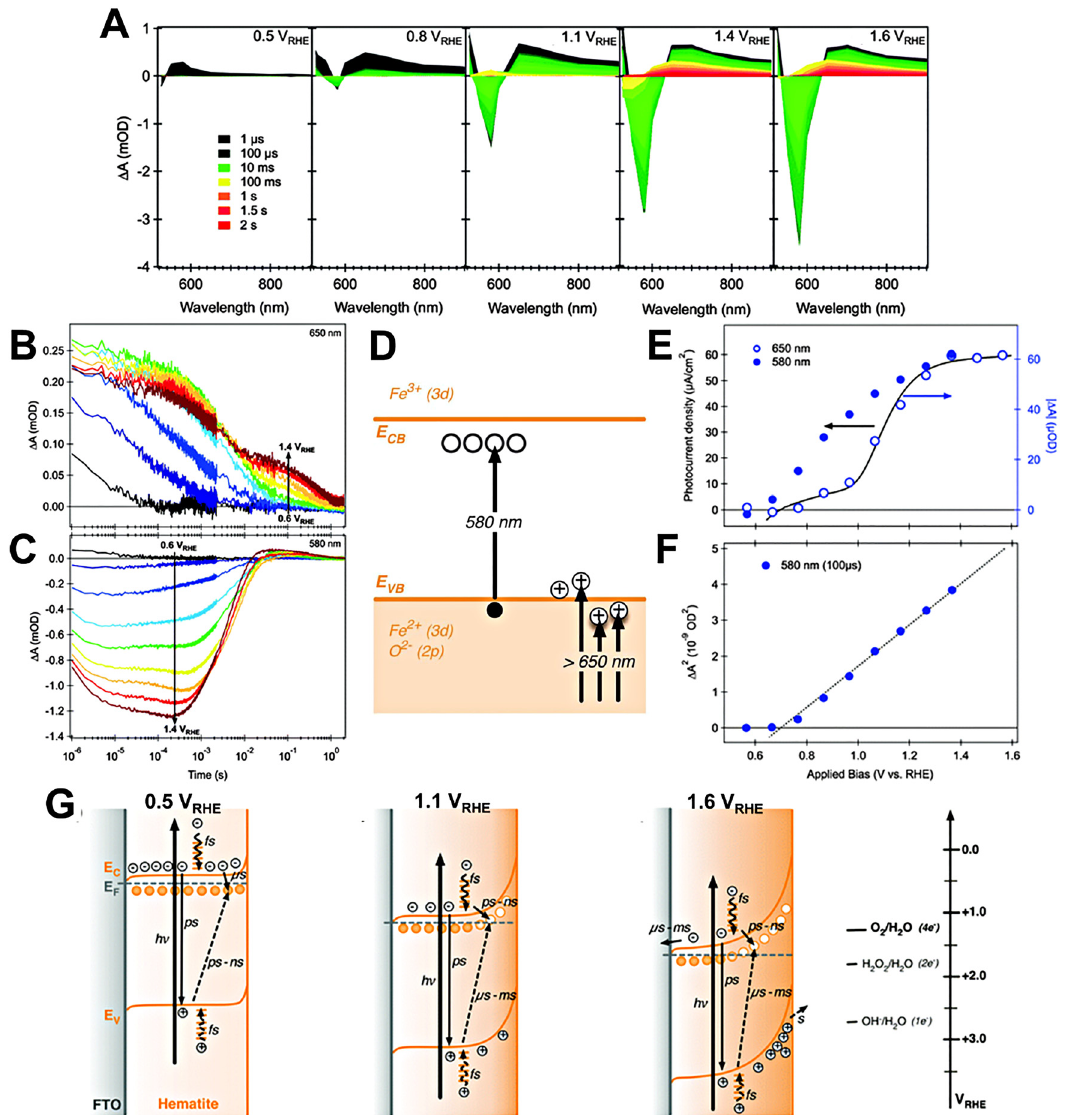
Figure 7: (A) In situ transient absorption (TA) spectra of Si-doped α -Fe 2 O 3 photoanode at different applied biases after UV excitation (355 nm, 200 μ Jcm − 2 ).(B,C)TApro fi lesat650nm(bpanel)and580nm(Cpanel)atdifferentappliedbiases.(D)OriginsofthetwoTAsignalsat650and 580 nm. (E) Correlation between the photocurrent and TA amplitude at 650 and 580 nm at 100 ms after UV excitation under different applied biases. (F) Dependence of the square of the TA amplitude at 580 nm and 100 μ s after UV excitation on the applied bias. (G) Proposed charge dynamicsmechanismof α -Fe 2 O 3 underdifferentapplied biases.Reprinted with permissionfrom a study by Barrosoet al. [47]. Copyright 2013 Royal Society of